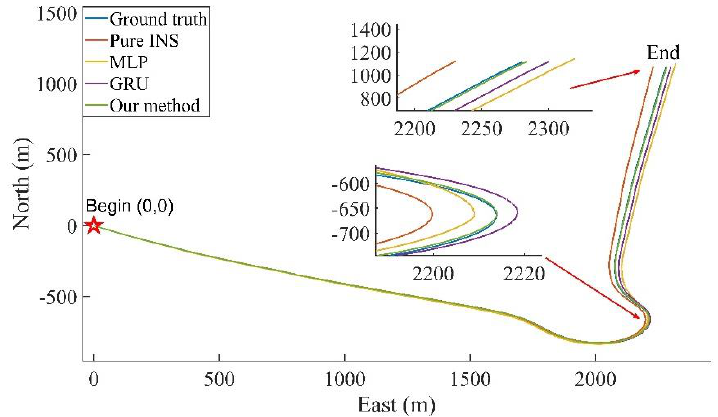
Figure 15. The trajectories of 180 s outage of Experiment 1. Table 3. Maximum position error of 180 s outage of Experiment 1.